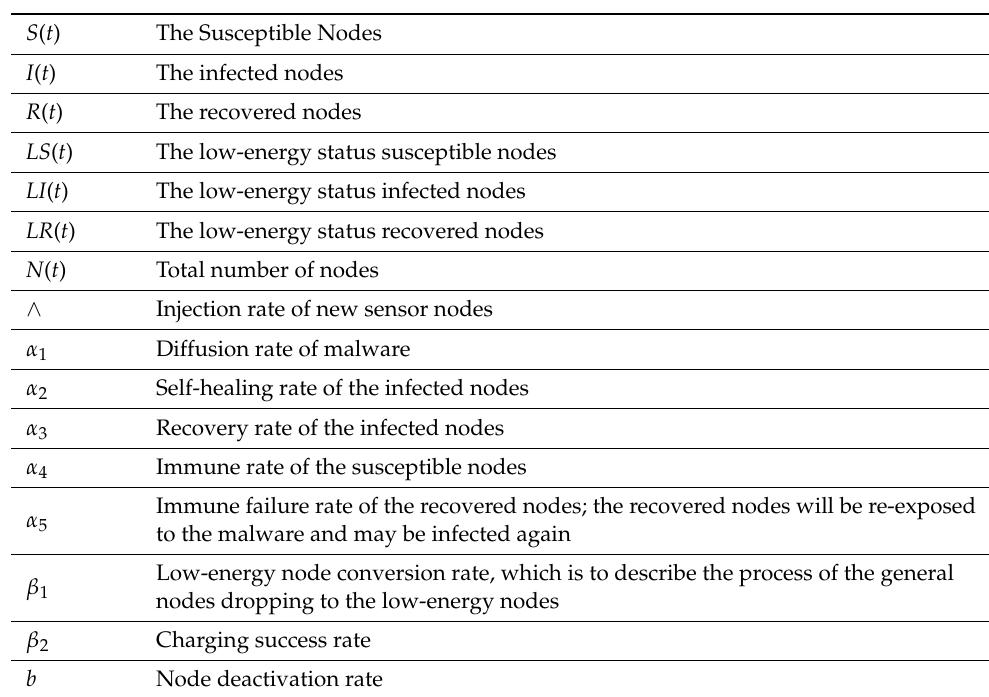
Table 2. Interpretation of the model